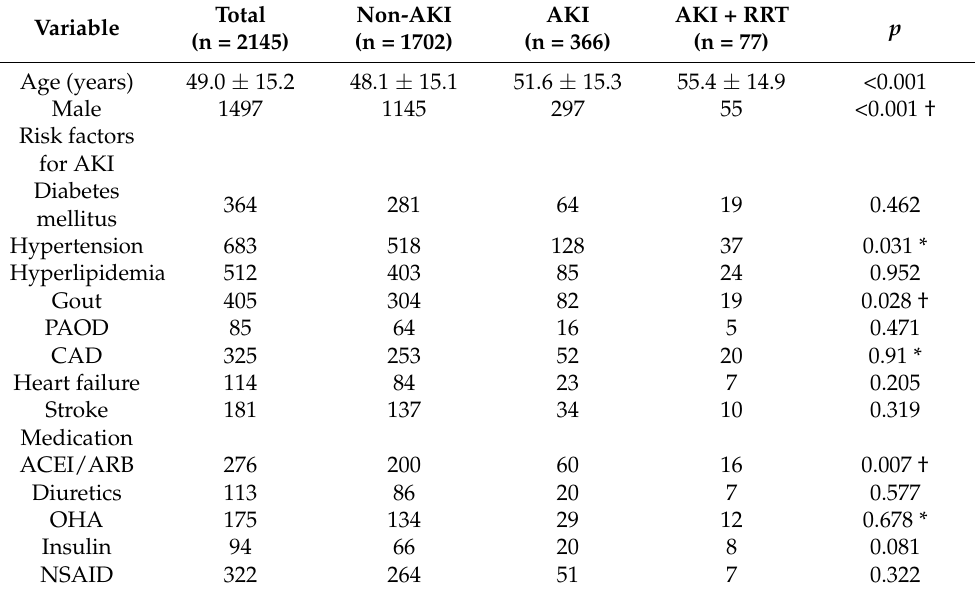
Table 1. Baseline patient profiles.